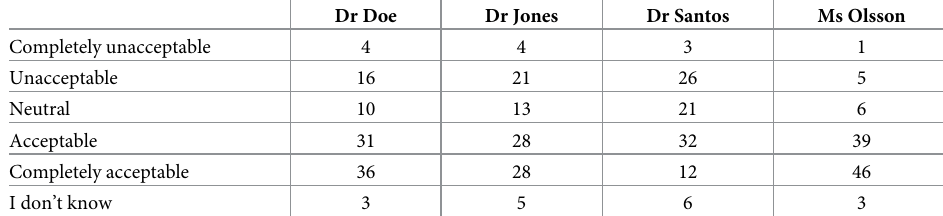
Table 14. Participants’ beliefs about whether it would be acceptable to include each of the four collaborators as co-authors of a publication they had contributed to in varying degree (details in Section 2.4.2). Shares are reported as column percentages ( n =